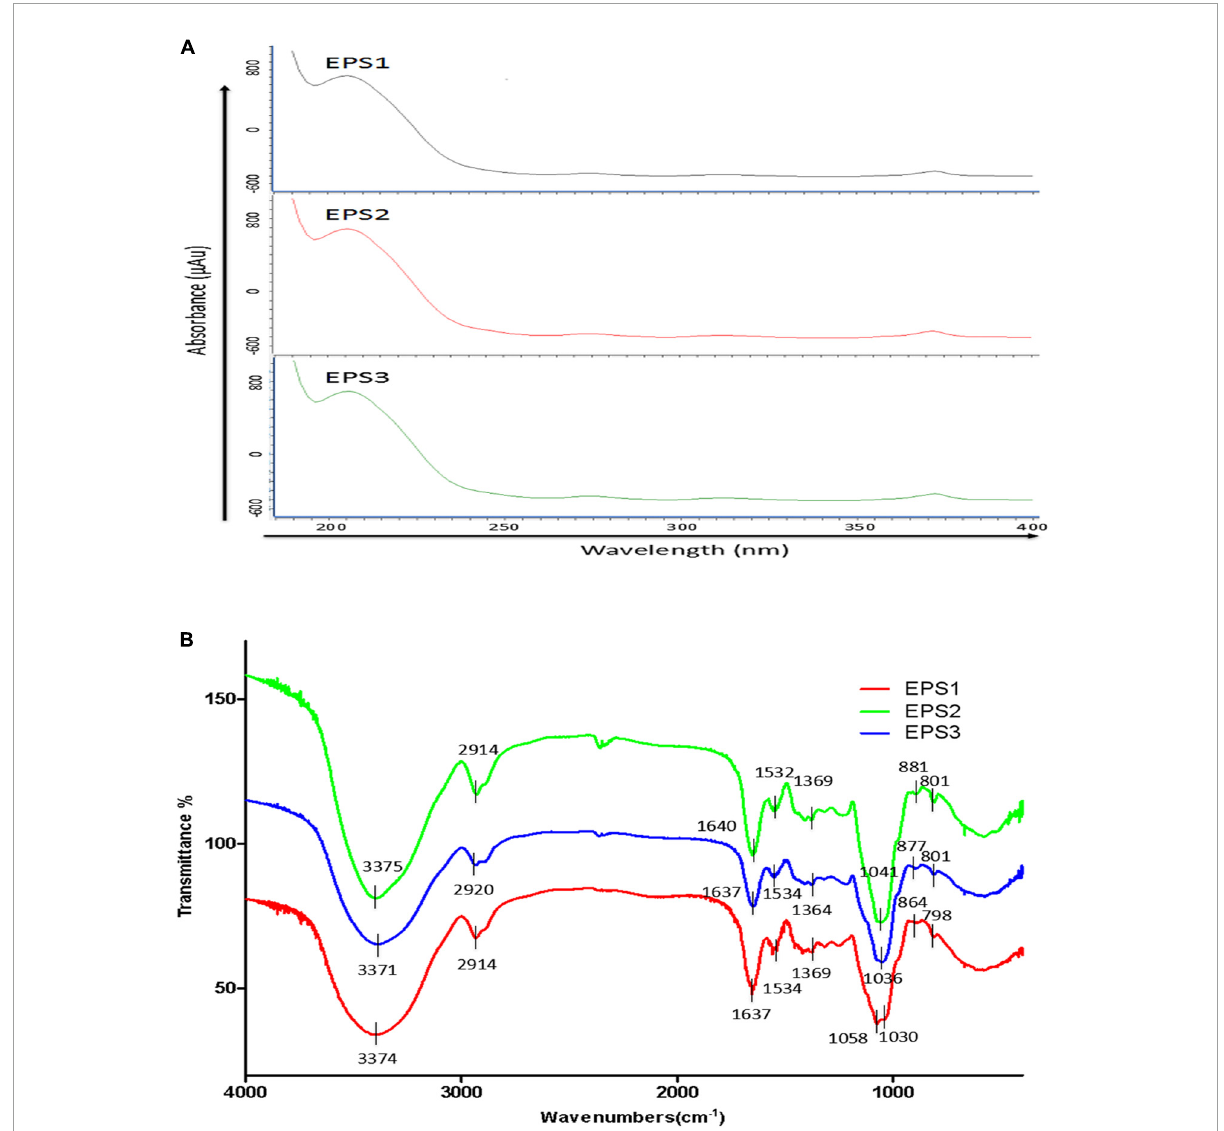
FIGURE5 UV and FT-IR spectrometric analysis. (A) UV spectra of EPSs in the range of 180–540 nm. (B) FT-IR spectra of EPSs in the range of 600–4,000 cm − 1